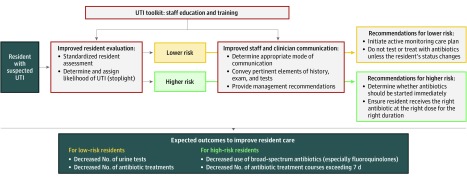
Wisconsin UTI Improvement Toolkit Logic ModelUTI indicates urinary tract infection.